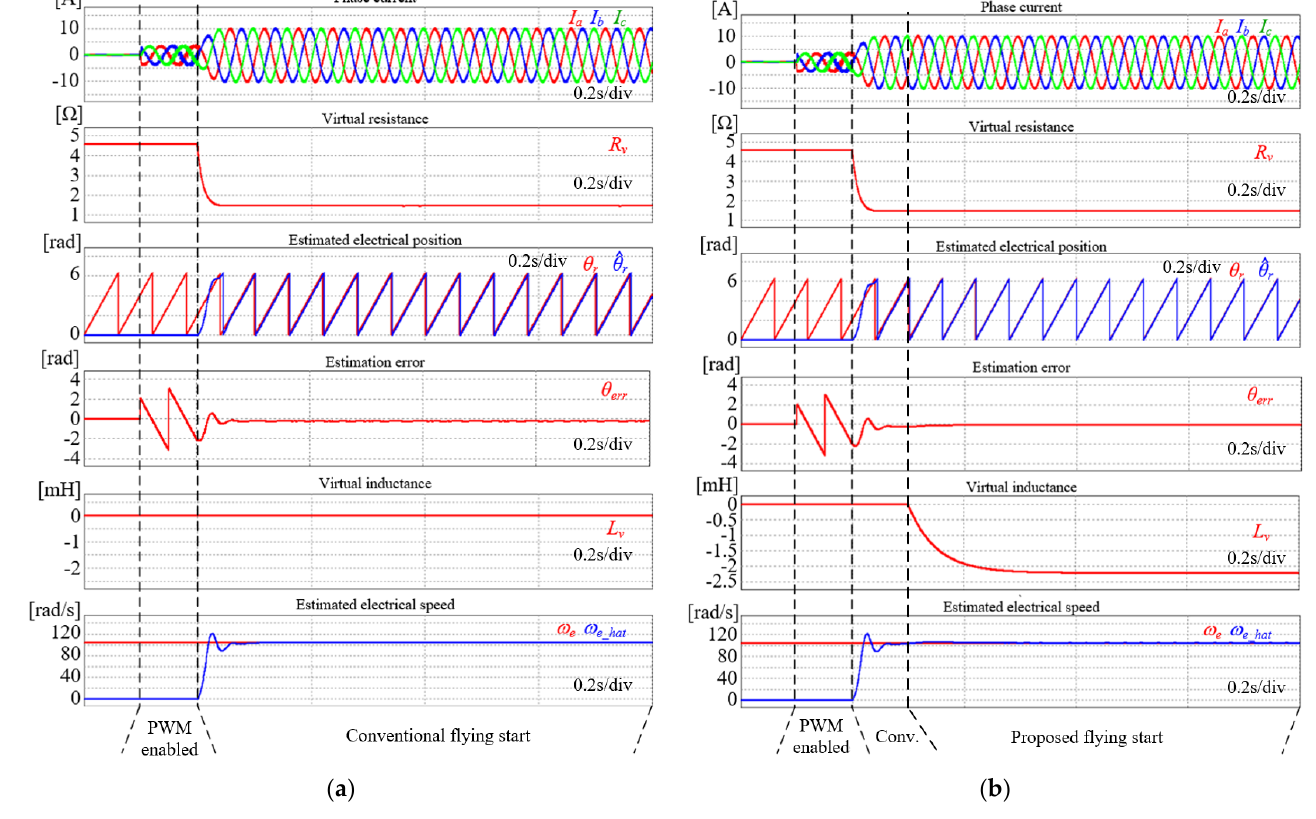
Figure 10. A comparison of the conventional flying start method and the proposed flying start method with added VI at 500 rpm. ( a ) The conventional method and ( b ) the proposed method.